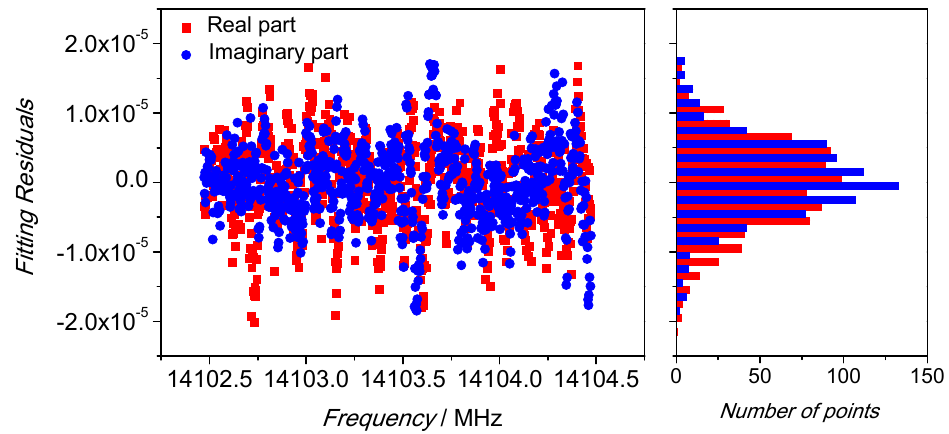
Figure 7. Residuals of the Lorentzian fitting. The scatter is within ± 2 × 10 − 5 of the S 21 transmission coefficient scale; their probability distribution function is normal as a proof of a good mathematical modeling of the resonance.